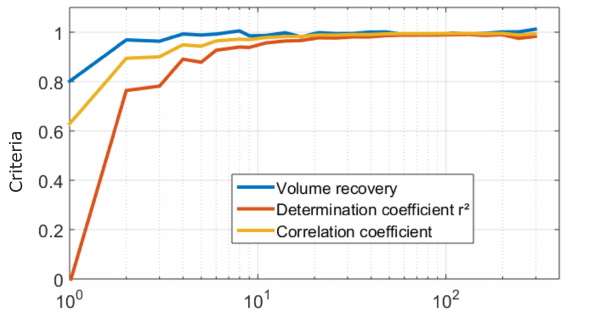
Figure B2. Impact of integration time on recharge volume, de- termination coefficient r 2 and correlation coefficient between in- ferred and true (initially imposed to the numerical ModFlow model) recharge. “Volume recovery” refers to the ratio between inferred and true mean annual amplitude.